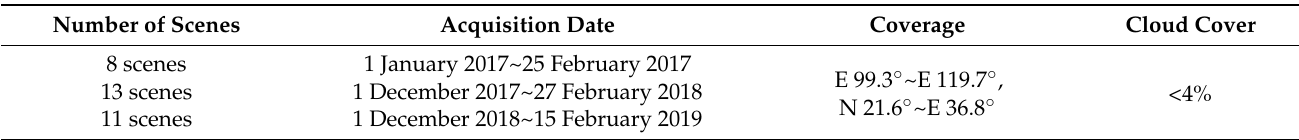
Table 1. Description of Gaofen-1